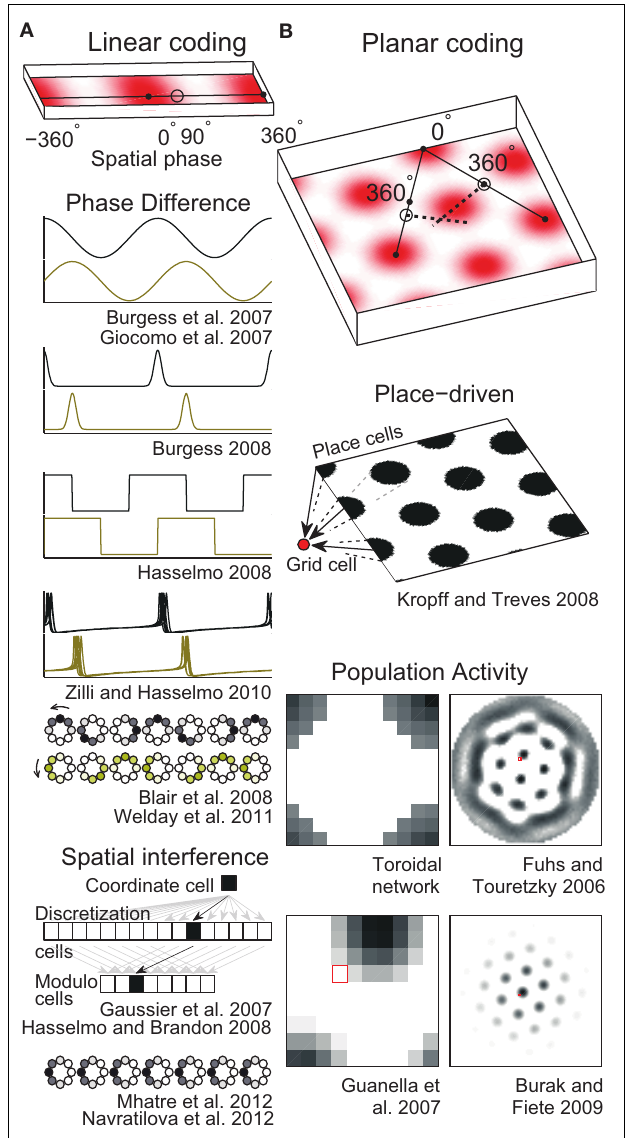
FIGURE 2 | Spatial position codes. (A) Linear-coding models.Top. A linear track environment with three grid fields. Positions can be identified as a spatial phase between 0˚ in the center of one field and 360˚ (0˚) at neighboring fields. One-quarter of the distance between the field centers, 90˚, is indicated. Some models (Burgess et al., 2007; Giocomo et al., 2007; Blair et al., 2008; Burgess, 2008; Hasselmo, 2008; Zilli and Hasselmo, 2010; Welday et al., 2011) store the 90˚ linear position as a 90˚ phase difference between two oscillators. An unbiased (stationary) ring attractor (Mhatre et al., 2012; Navratilova et al., 2012) can also directly store the 90˚ phase as a bump of activity centered on cells in the ring at a corresponding angle. Instead of encoding position as a phase, the animal’s actual position or coordinate could be stored as the firing rate of a single cell (Gaussier et al., 2007). Hasselmo and Brandon (2008) described one model using only coordinate cells and another using only modulo cells. (B) Top. A square environment with many grid fields. Linear-coding models can encode 2D positions as two spatial phases, now measured between rows of grids, not neighboring grid fields (so only alternate 0˚ points are field centers). For example, a position at 0˚ along one direction and 90˚ along the other